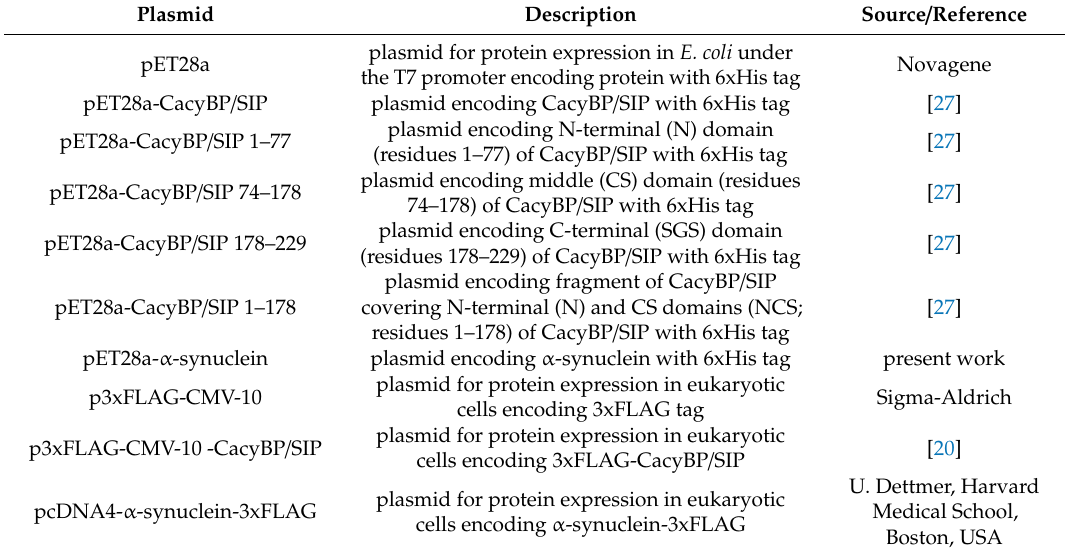
Table 1. List of plasmids used for protein purification and for cell